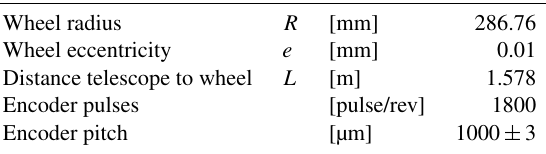
Table 1. Physical properties of the calibration